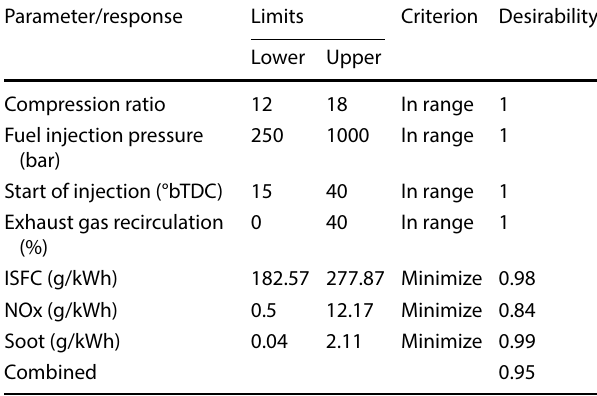
Table 6 Criteria of optimization used for desirability method for VCR diesel